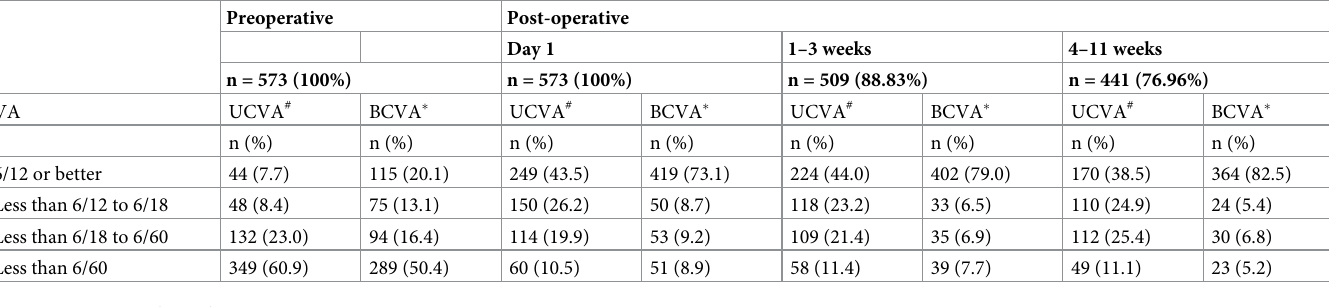
Table 2. Uncorrected and best corrected visual acuity at different follow-up